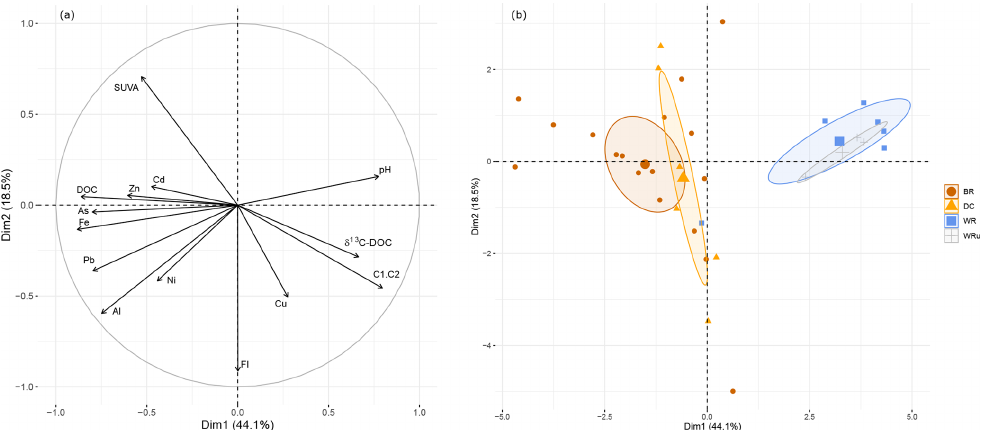
Figure 5. The first two factors of the PCA (62.6% of variance) by variables (a) and by observations (b) for the different sampled water types.